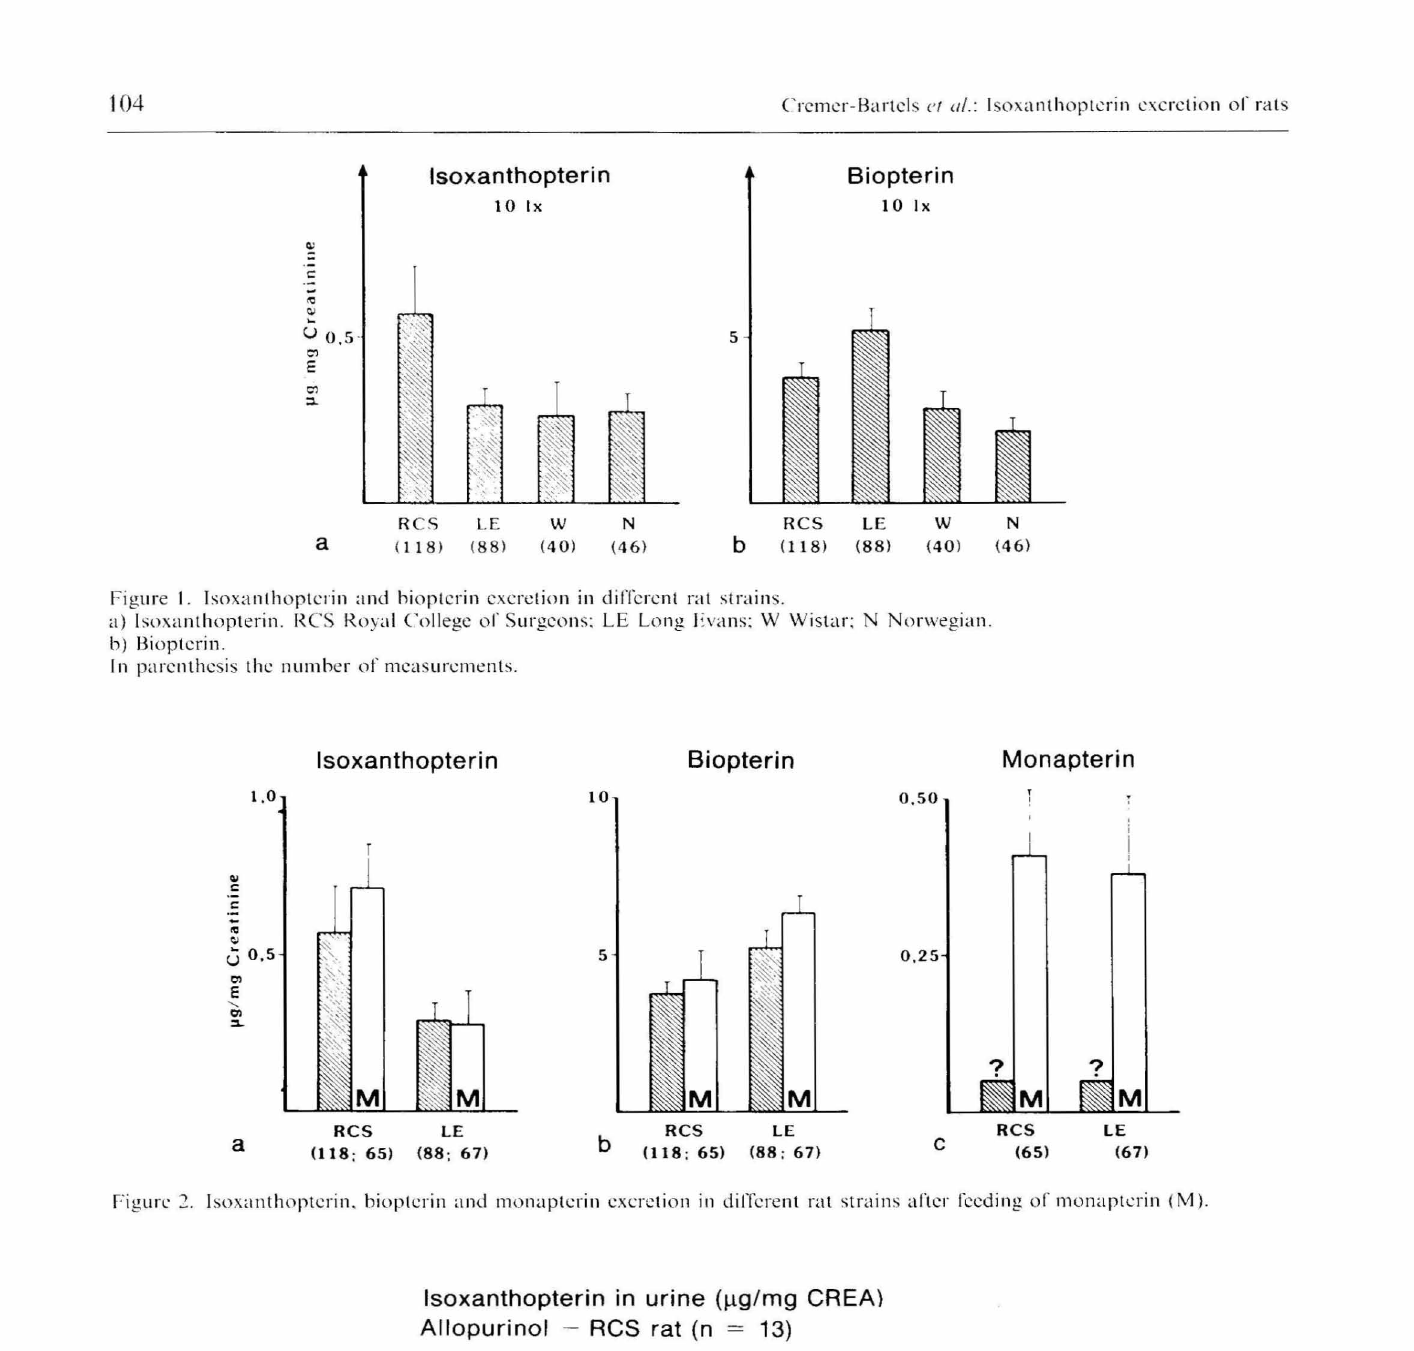
Figure 2. Isoxanthopterin, biopterin and ll10napterin cxcretion in dirrerent rat strains after feeding of monaptcrin (M).